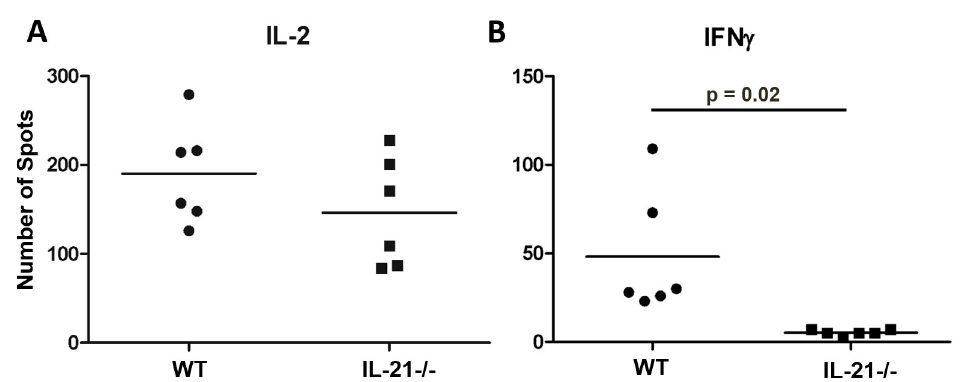
by ELISpot assay in technical triplicates of n = 2 mice. P value from unpaired Student’s t-test.